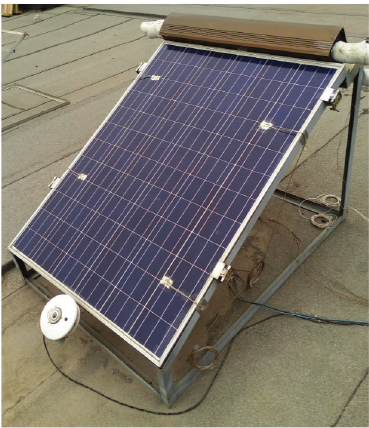
Figure 1: The testing rig of the PV-HP solar collector.